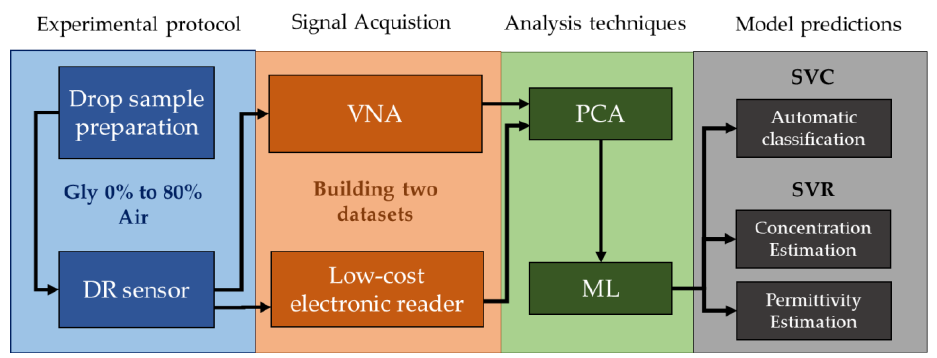
Figure 1. Summary of the experimental workflow.